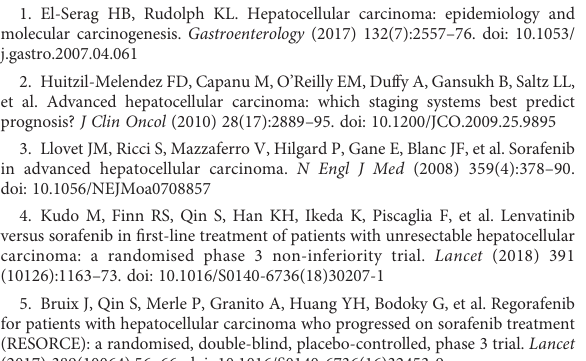
SUPPLEMENTARY FIGURE 2 Effects of speci fi c downregulation of GHR by siRNA. HCC cell lines were transfected with scrambled siRNA or with GHR siRNA for 48 and 72 h. Compared with scrambled siRNA, GHR siRNA induced signi fi cant decrease † P < 0.05 vs. GHR siRNA in cell viability (A) *P < 0.0001 vs. scrambled siRNA; ‡ P < 0.001 vs. scrambled siRNA, proliferation (B) *P < 0.0001 vs. other [72 h]; † P < 0.001 vs. scrambled siRNA; § P < 0.0001 vs. scrambled siRNA; conditions; ¶ P < 0.001 vs. GHR siRNA [48 h], adhesion (C) *P < 0.0001 vs. scrambled